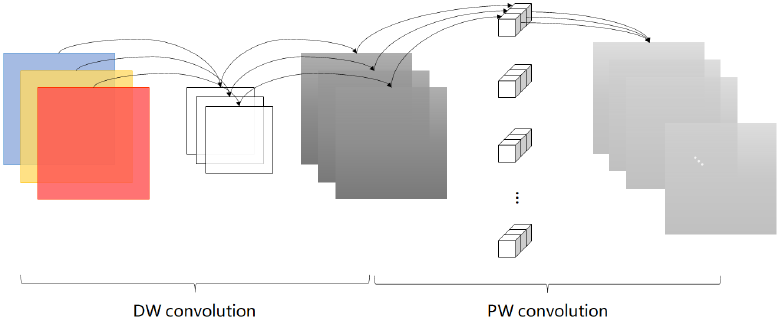
Figure 5. The principle of depthwise separable convolution.